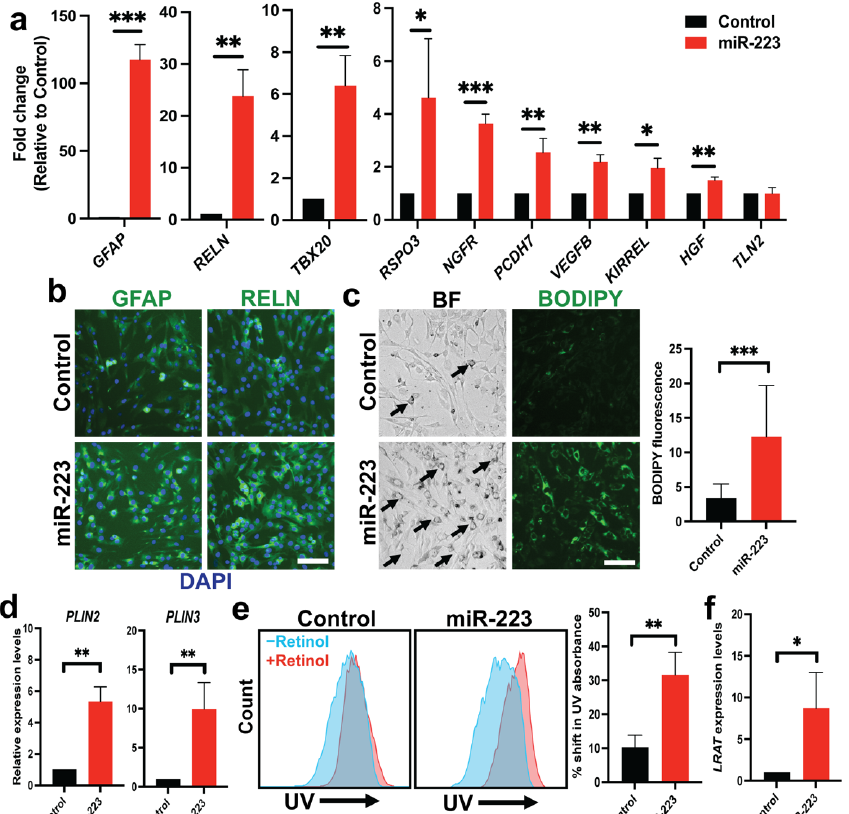
Figure 2. miR-223 promotes quiescent phenotypes of human HSCs. ( a ) RNA expression of quiescent HSC genes upon overexpression of miR-223 determined by qRT-PCR. ( b ) Expression of GFAP and RELN in control and miR-223 HSCs by immunofluorescence. ( c ) Formation of cytoplasmic lipid droplets upon incubation with palmitic acid (100 μM) in control and miR-223 HSCs visualized by bright field (BF) microscopy and BODIPY staining. Black arrows indicate cells with perinuclear lipid droplets. ( d ) Expression levels of genes that encode lipid droplet proteins PLIN2 and PLIN3 by qRT-PCR. ( e ) UV autofluorescence of control and miR-223 HSCs determined by flow cytometry. ( f ) RNA expression levels of lecithin:retinol acyltransferase (LRAT) by qRT-PCR. Data presented as the mean ± SD and expressed relative to those of control HSCs (set as 1.0) for qRT-PCR experiments. N = 3–4 replicates per group from at least two independent experiments. Student’s t -test; * = p < 0.05, ** = p < 0.01 and *** = p < 0.001. Fluorescent images taken at equivalent exposure for comparison. Scale bars, 100 μm. DAPI: 4′,6 -diamidino-2-phenylindole. BODIPY: 4,4-Difluoro-1,3,5,7,8-Pentamethyl-4-